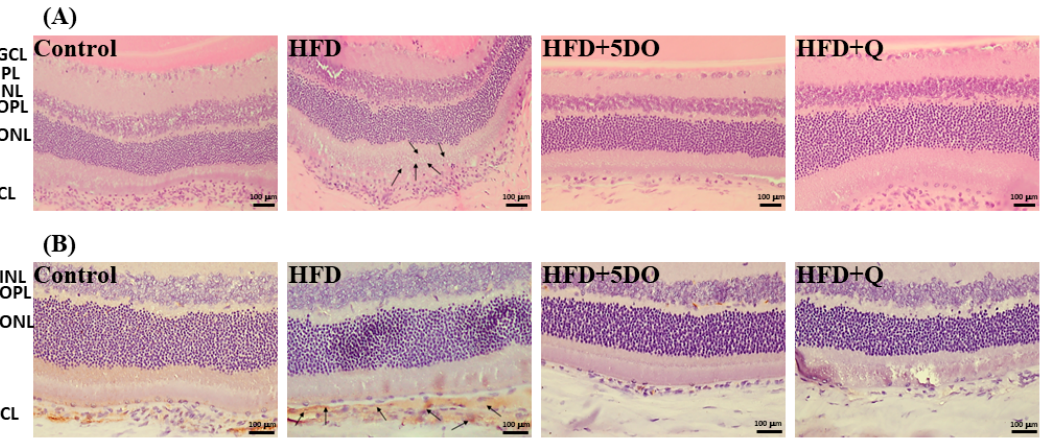
Figure 3. Effect of dried onion powder and quercetin on retinopathy. HE staining images with arrows indicated the adipose-deposition ( A ) and histological images stained with CD-31 antiserum ( B ) in retina of rats exposed to HFD. Scale bar, 100 μ m. The CD-31 positive areas were pointed by arrows. The animals were treated with a high fat diet (HFD) along or supplemented with dried onion powder (5%; 5DO) or quercetin (Q) for 12 weeks. The control group was given the control diet. GCL, ganglion cell layer; IPL, inner plexiform layer; INL, inner nuclear layer; OPL, outer plexiform layer; ONL, outer nuclear layer; CL, choroid layer.